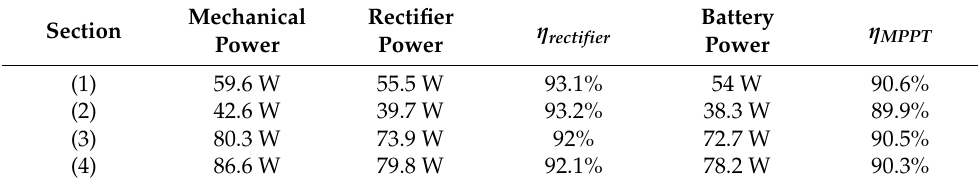
Figure 8. Overall power converter final prototype: ( a ) 3D model; ( b ) power converter final prototype. 5. Results The test setup comprised a power converter, a linear machine, an oscilloscope, and an electronic load. Based on the modeling described in the previous section, the output of